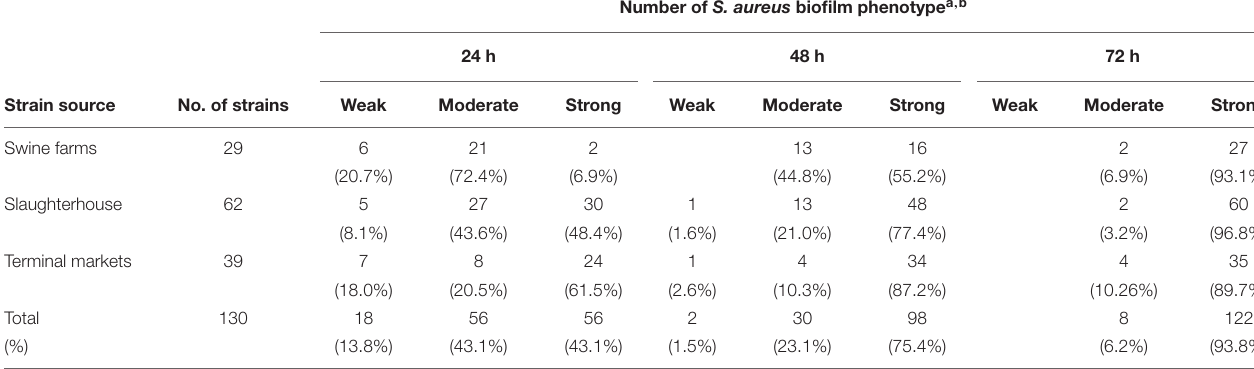
TABLE 4 | Biofilm phenotype of 130 S. aureus isolates at different time points.